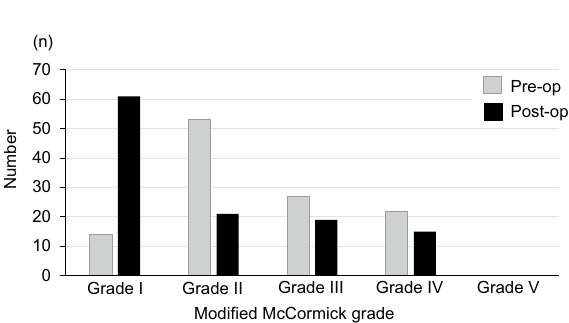
Figure 4. Modified McCormick grade for preoperative and postoperative neurological